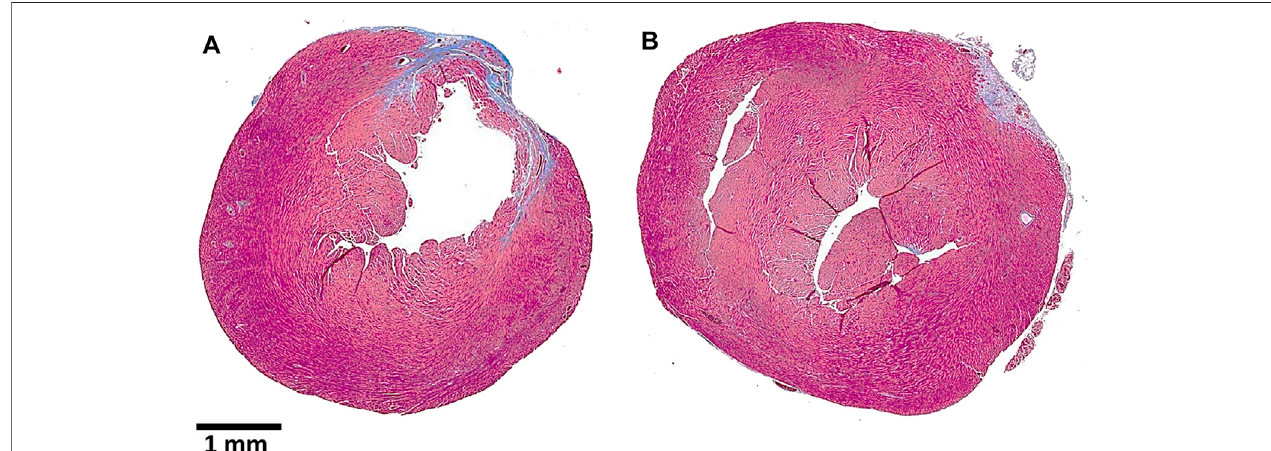
FIGURE 10 | Post – myocardial infarction (MI) repair of the left ventricular wall in representative anti-Gal – producing mice receiving intramyocardial injection of saline (A) or α -galnanoparticles (B) .TheMIwascausedbya30-minocclusionoftheleftanteriordescending(LAD)coronaryartery,followedbyreperfusion,andtwoinjections of10 μ lsaline (A) orof100 μ g α -galnanoparticlesinsaline (B) .Theheartswereharvested after28 days,sectioned,andstainedwithTrichrome, whichstainsscartissue containingcollagenblueandhealthymyocardiumdarkred.Notethethinningoftheventricularwallandthemuchlargerscartissueinthesaline-treatedheartvs.the normal ventricular wall thickness and much smaller scar in the α -gal nanoparticle – treated heart. Adapted from Galili et al.